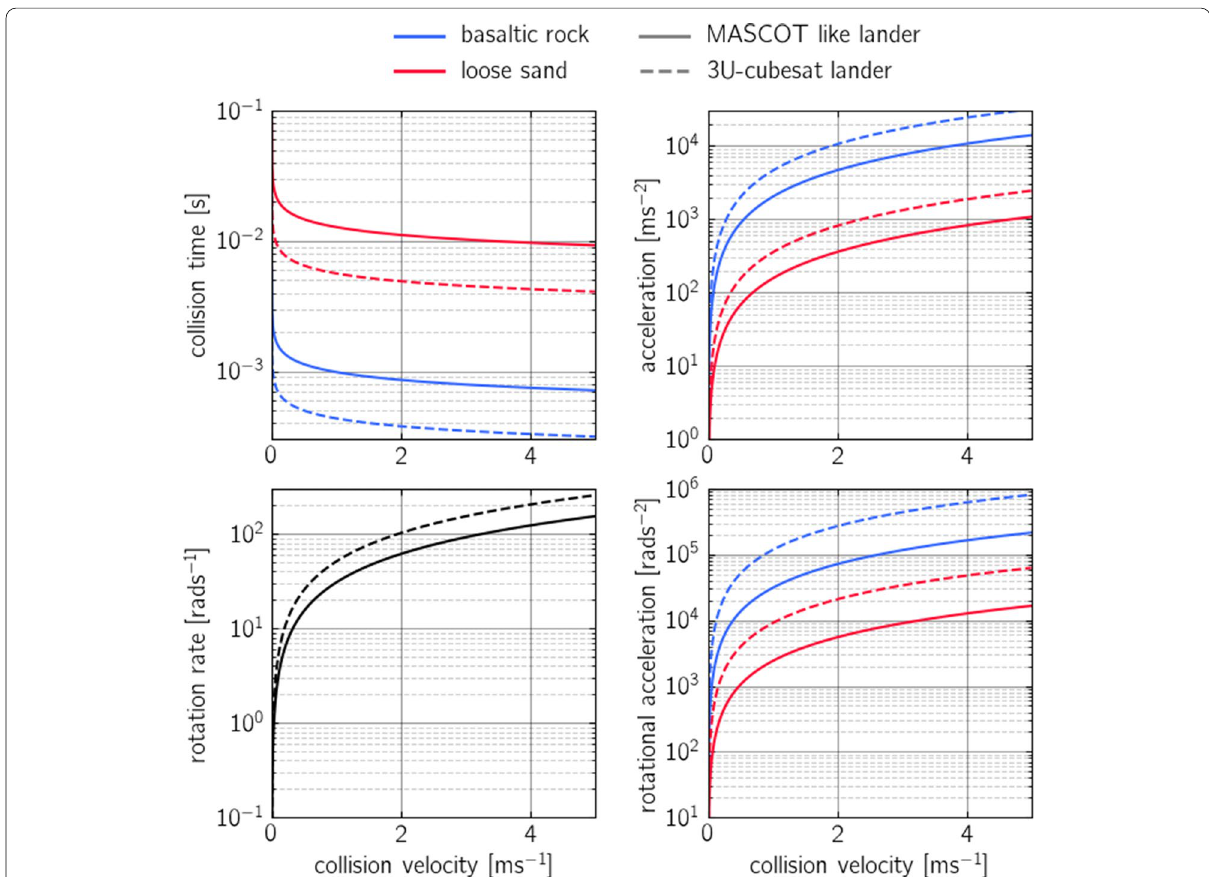
Fig. 2 Lander–surface interaction. Estimated collision time (upper left), and the derived maximum transverse acceleration (upper right) for two different surface materials (loose sand and basaltic rock) as well as for two different lander types (a MASCOT‑like lander and a 3‑unit cubesat lander). Maximum rotation rate (lower left) and rotational acceleration (lower right) can be derived under assumption of total energy